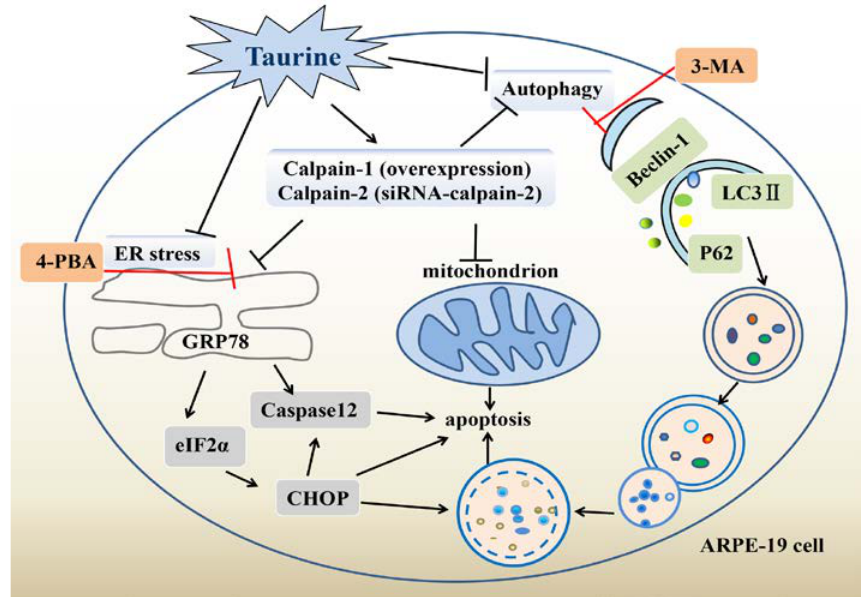
Figure 1. Schematic diagram of the protective effects of taurine in ARPE-19 cells. In starved cells, the calcium homeostasis was eliminated, and autophagy, endoplasmic reticulum (ER) stress and apoptosis were activated. Furthermore, taurine inhibits starvation-triggered endoplasmic reticulum stress, autophagy, and apoptosis in ARPE-19 cells by modulating the expression of calpain-1 and calpain-2. The red & black T-bars stands for inhibition.